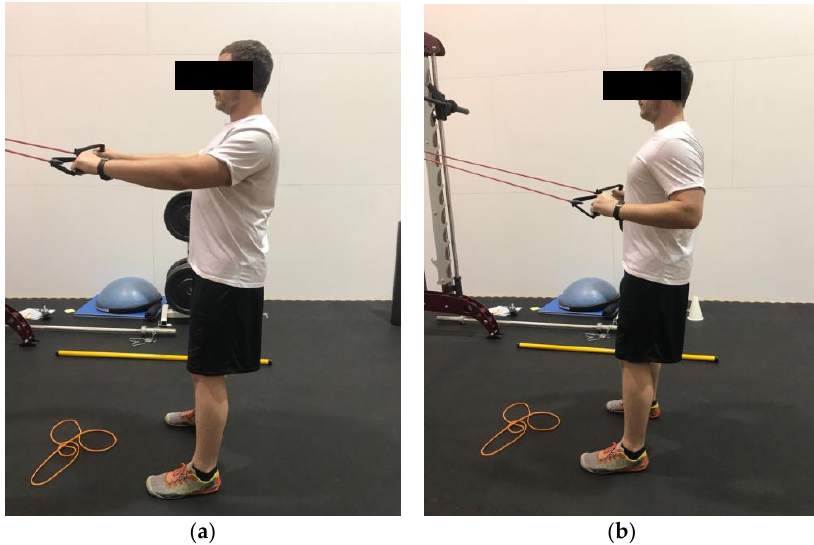
Figure 5. Demonstration of banded high pull in the ( a ) start position; ( b ) end position. The scapula is required first to be retracted and depressed. The band is then pulled to the chest.